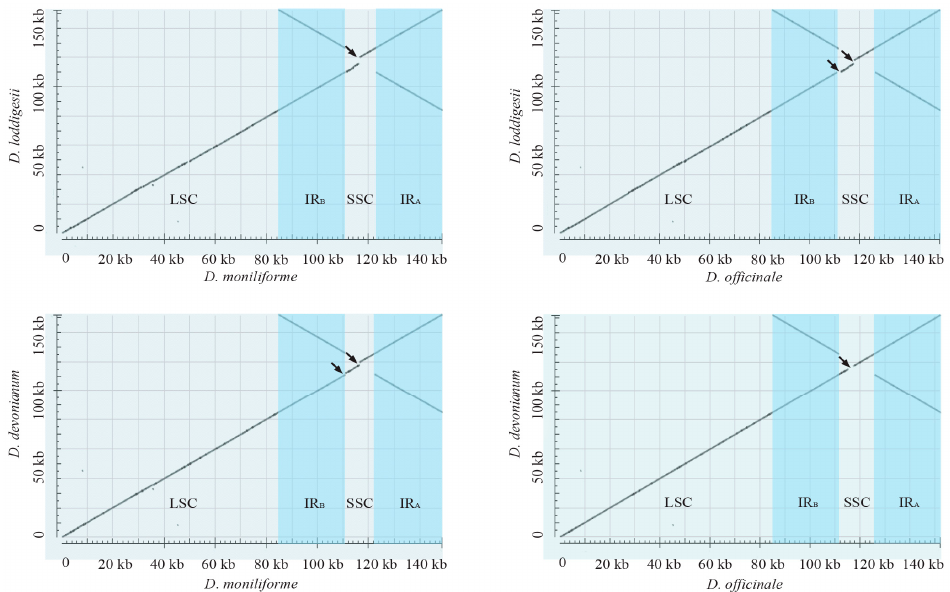
Figure 2. Dot-plot analysis of the four Dendrobium plastomes. The Dendrobium plastomes appear to have a nearly identical organization, which indicates that their plastomic organization is highly conserved. The black arrows indicate the different loss/retention of ndh genes.